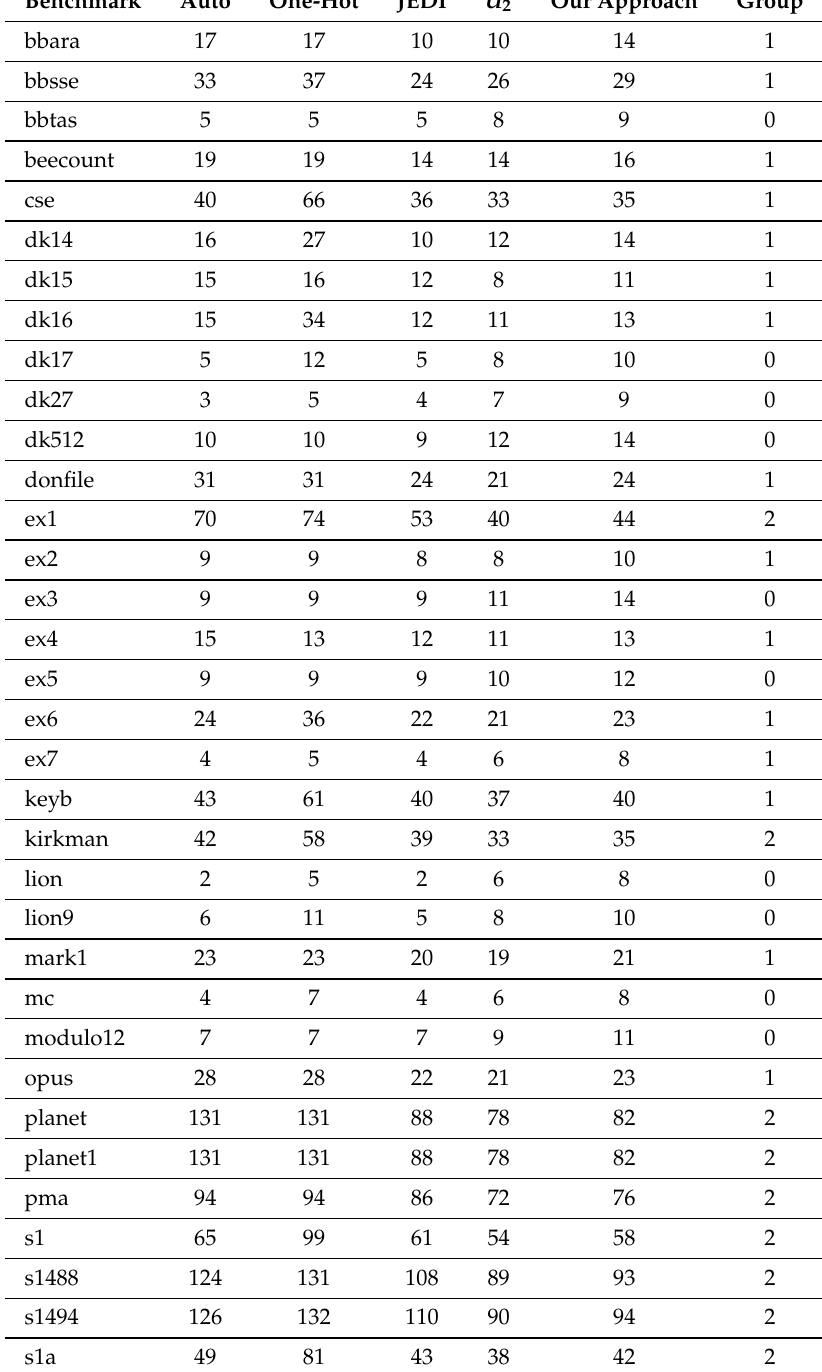
Table 7. Results of experiments (LUT